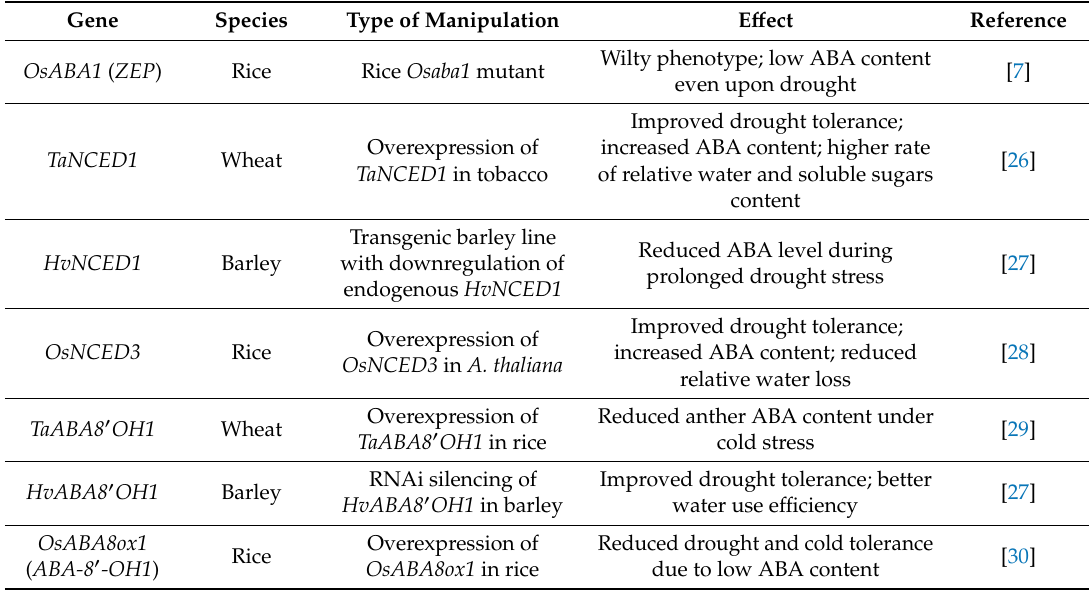
Table 1. Contribution of genes encoding enzymes involved in ABA metabolism in response to abiotic stresses in